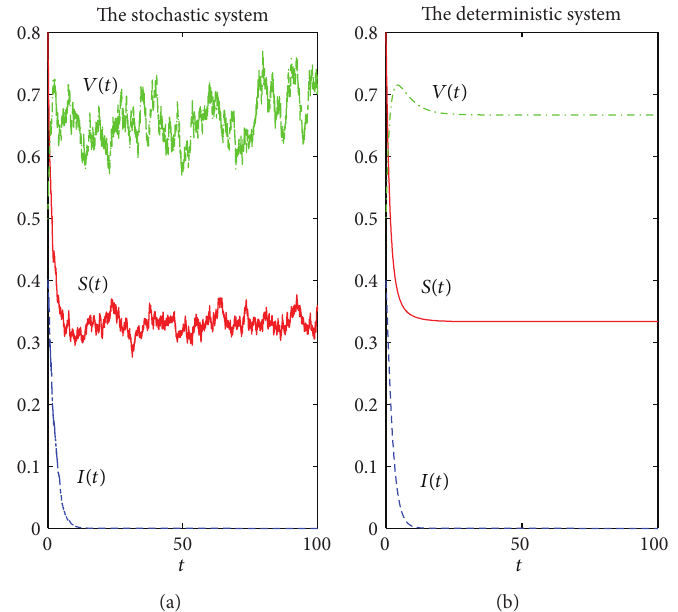
Figure1:Computersimulationofthepaths 𝑆(𝑡) , 𝐼(𝑡) ,and 𝑉(𝑡) fortheSDESISmodel(6)withvaccinationanditscorrespondingdeterministic model (1) for parameter values 𝐴 = 0.2 , 𝑞 = 0.5 , 𝛽 = 0.5 , 𝜇 = 0.2 , 𝑝 = 0.3 , 𝛾 = 0.2 , 𝜀 = 0.1 , 𝛼 = 0.3 , 𝜎 1 = 0.05 , 𝜎 2 = 0.1 , and 𝜎 3 = 0.05 . can be imagined a circular or elliptic region centered at 𝑃 ∗ (𝑆 ∗ , 𝐼 ∗ , 𝑉 ∗ ) (see the red point in Figure 3). All of these imply system (6) has stochastic